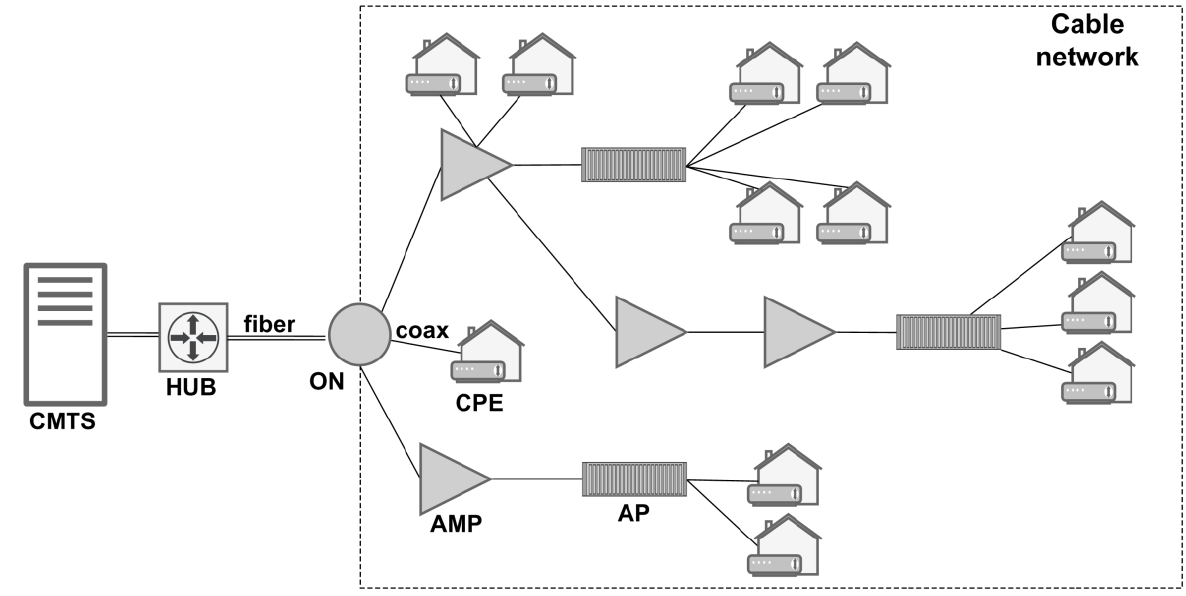
Figure 1. Architecture of the HFC network.